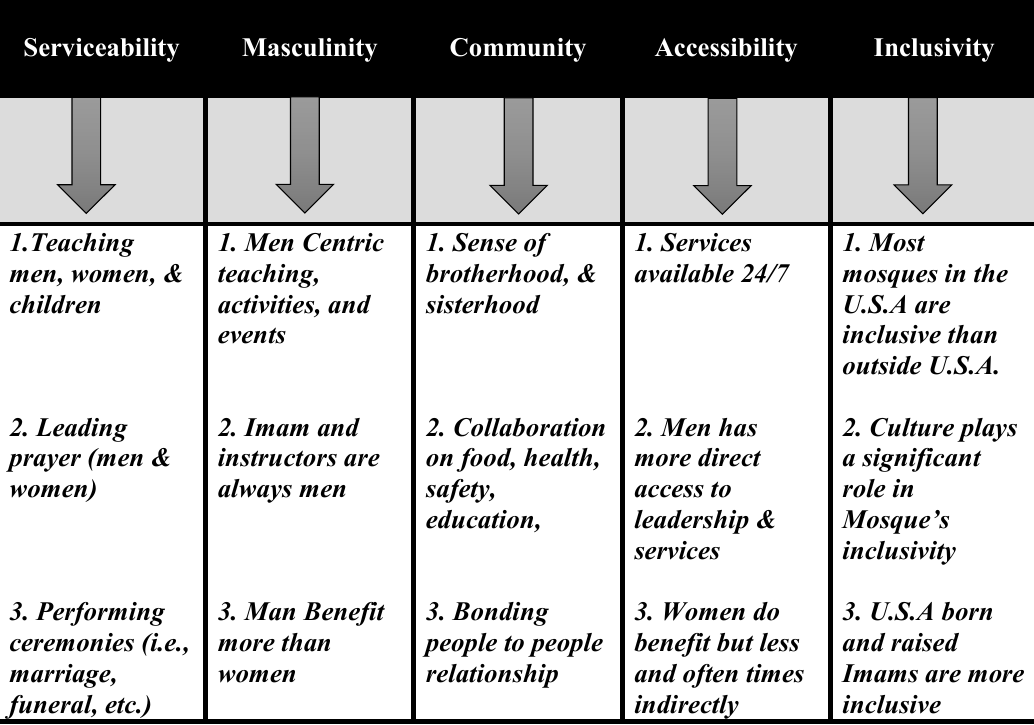
Figure 1. Depicts recurring themes.